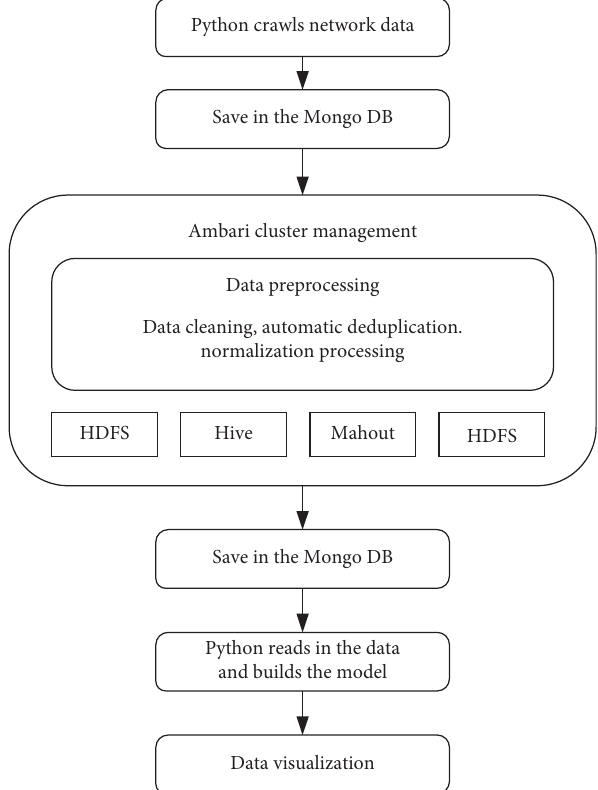
Figure 2: Schematic diagram of data processing